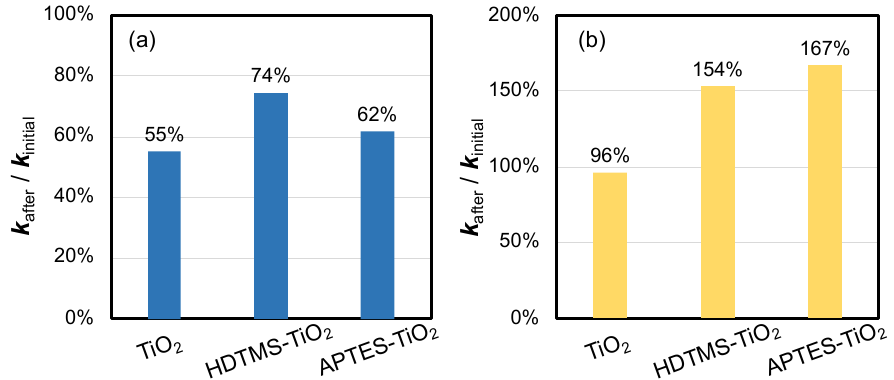
Figure 5. Effect of ( a ) water flow and ( b ) strong artificial sunlight irradiation on the photocatalytic degradation of MB.